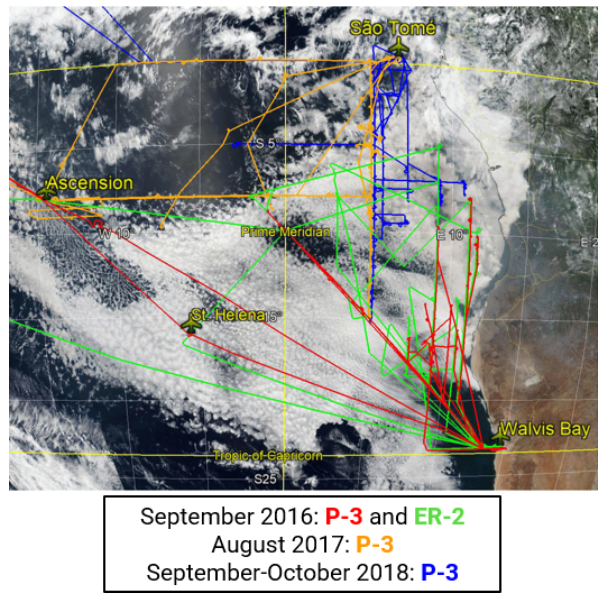
Figure 1. Adapted from Redemann et al. (2021), ORACLES flight tracks over the southeast Atlantic are color-coded by year and air-